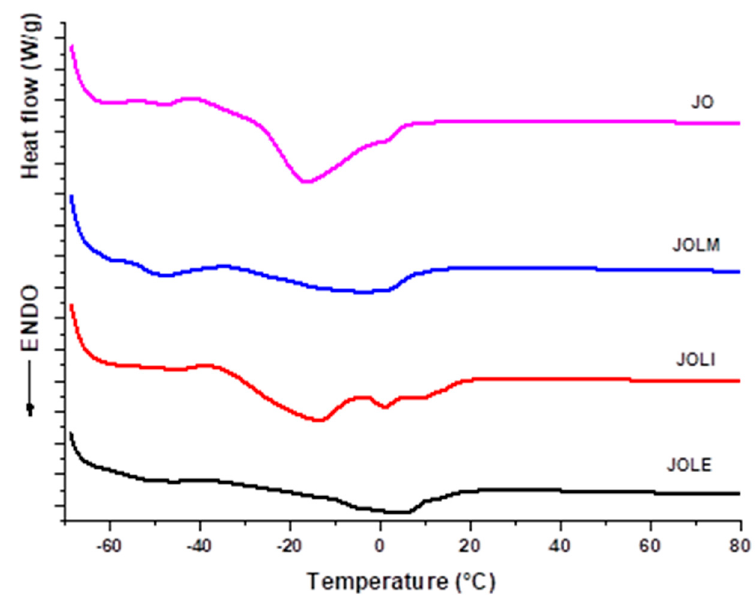
Figure 6. DSC plot for JO and polyols.